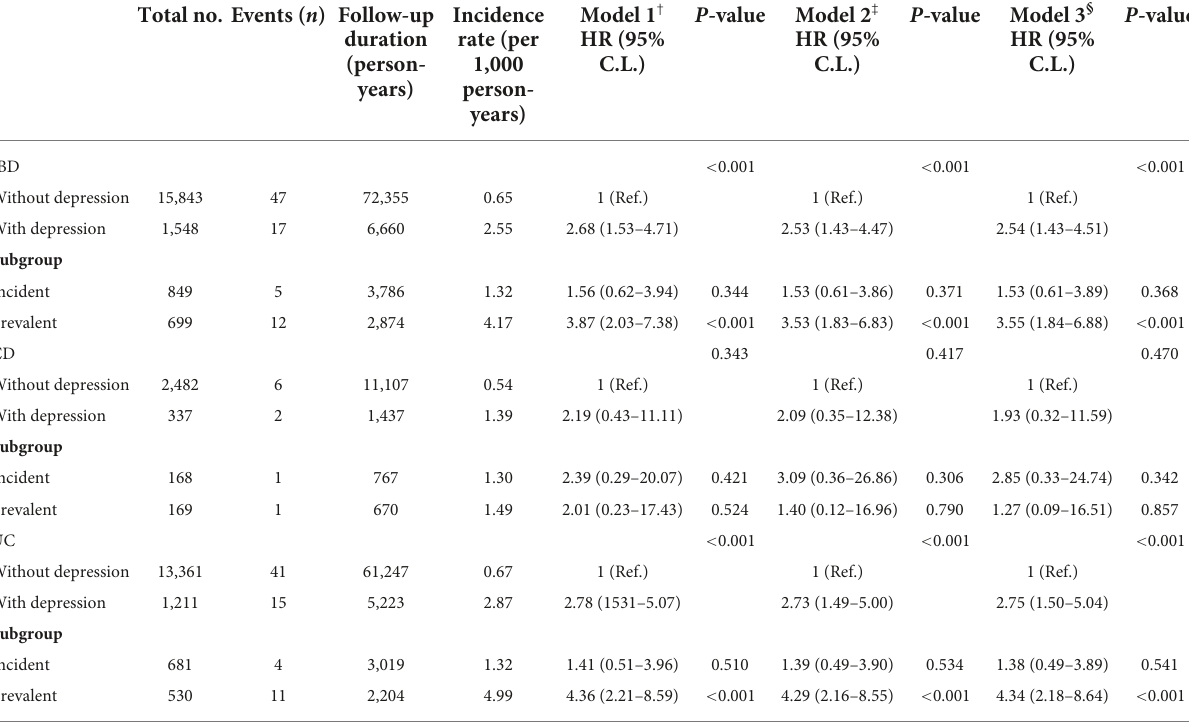
TABLE 4 Independent risk of Parkinson’s disease according to presence of depression in patients with inflammatory bowel disease (IBD). Total no. Events ( n ) Follow-up duration